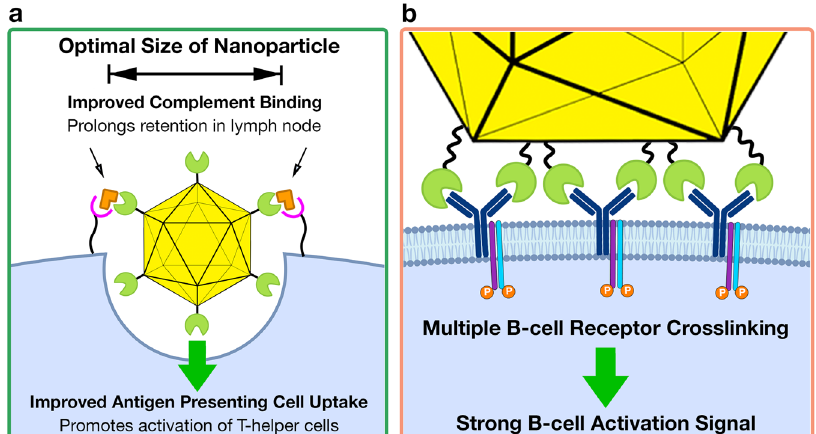
Fig. 2 Advantages of protein nanoparticle vaccines. Yellow icosahedrons represent a protein nanoparticle platform while green circular sectors represent a genetically fused antigen. a Bene fi cial effects of increased size by presenting antigen on a nanoparticle platform. One of these effects is improved binding of complement indicated by the rectangular orange shape, on the surface of the nanoparticle. The bound complement facilitates binding to complement receptors on APCs such as follicular dendritic cells and promotes retention of the opsonized nanoparticles in the lymph nodes. Another effect of increased size is enhanced uptake of nanoparticles by APCs, indicated by the circular cavity and direction of travel arrow into the APC, in light blue. b Enhanced B-cell activation through the interaction of multiple antigens with BCRs, which are embedded within the membrane of the